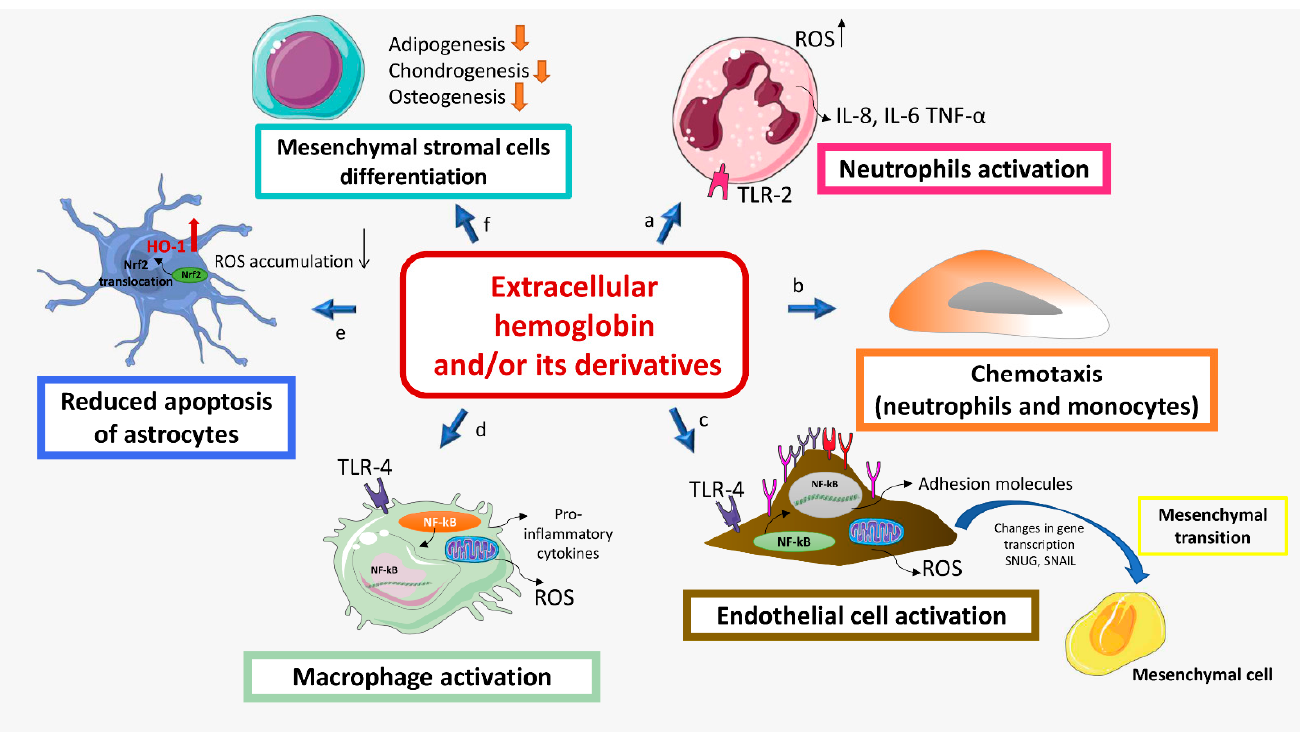
Figure 3. Targets of extracellular hemoglobin and its derivatives relevant for pathophysiology of several diseases (see Section 4). Extracellular hemoglobin and/or its derivatives induce ( a ) neutrophil activation characterized by elevated ROS production, increased production of pro-inflammatory cytokines, ( b ) neutrophil and monocytes chemotaxis, ( c ) endothelial cell activation characterized by NF- κ B activation, elevated ROS production, and increased expression of adhesion molecules and pro-inflammatory cytokines. ( d ) Macrophages elevated ROS production and pro-inflammatory cytokine production, ( e ) astrocytes reduced ROS accumulation and apoptosis rate characterized by upregulation and nuclear translocation of Nrf2 and HO-1 upregulation, ( f ) MSC reduced osteogenesis, chondrogenesis and adipogenesis. (NF- κ B, nuclear factor kappa B; ROS, reactive oxygen species; TLR2, toll-like receptor 2; TLR4, toll-like receptor 4, Nrf2, erythroid 2 related factor; HO-1 hem oxygenase-1; MSC-mesenchymal stromal cells).